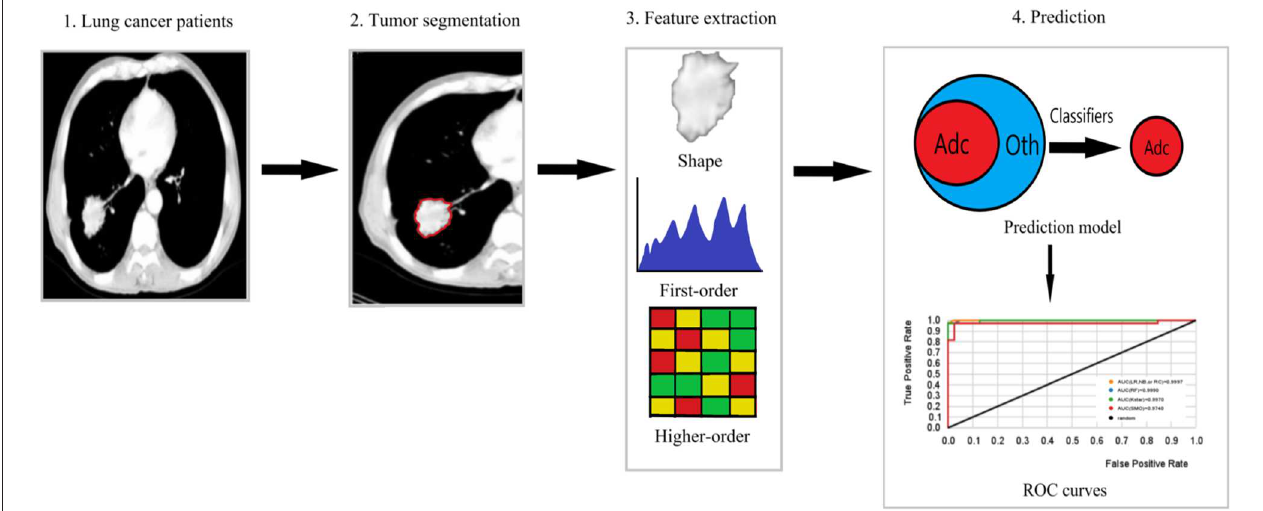
FIGURE 1 | The pipeline of our proposed radiomics analysis. (1) Original images of lung cancer patients. (2) Tumor area of interest (ROI) segmentation of each slice of CT. (3) Extraction of shape, first-order features and higher-order features from the ROI. (4) Prediction model building based on machine learning classifiers, ROC curves used to assess the model performance. Adc is lung Adenocarcinoma, and Oth are other lung cancer histological